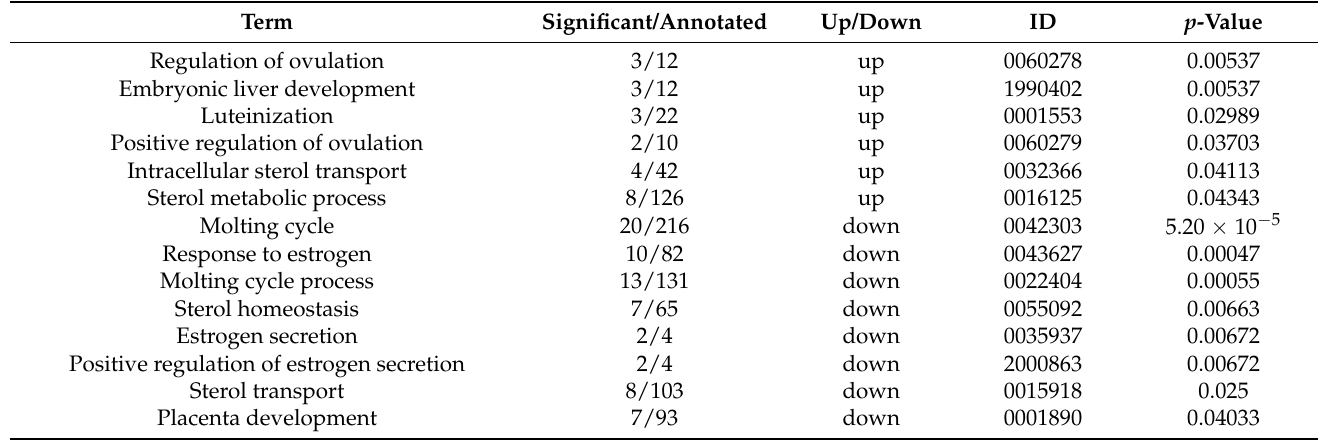
Table 2. The GO term of related to ovarian development in the LS_E vs. CG_E group. Term Significant/Annotated